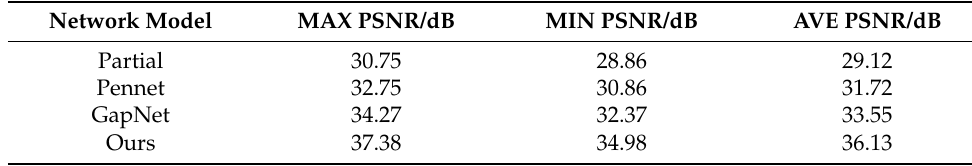
Table 1. PSNR comparison result.